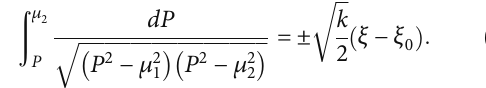
= 1, k = 3, ξ = 0, y = 1 1 3 0